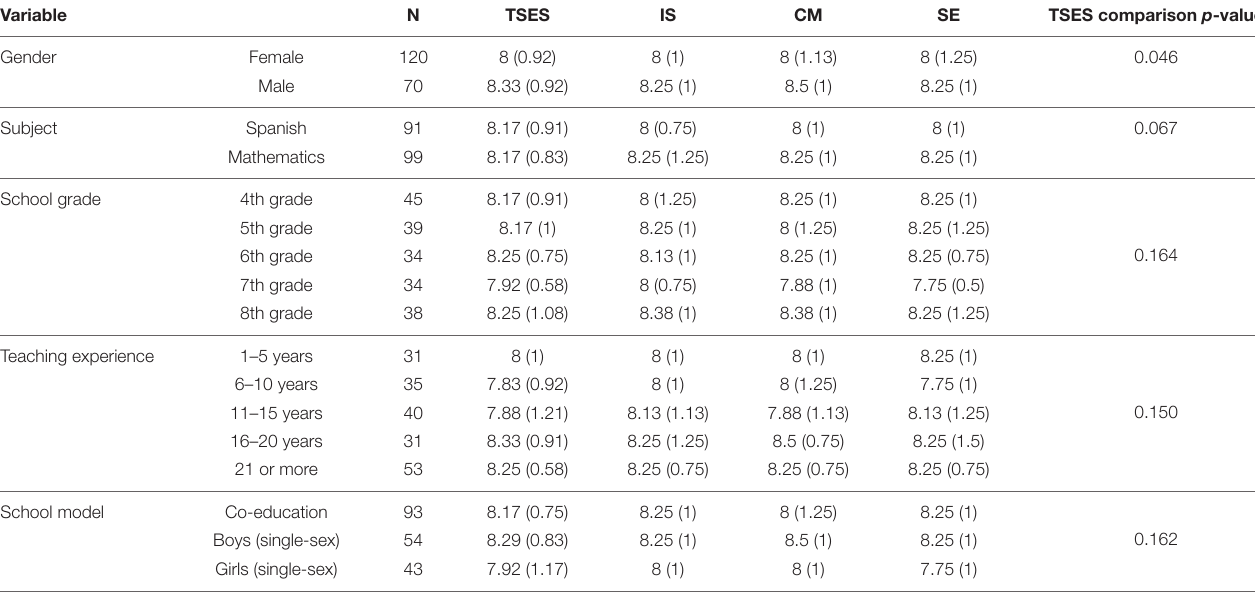
TABLE 5 | Medians and IQRs of teacher self-efficacy regarding participants’ demographic variables. Variable N TSES IS CM SE TSES comparison p -value